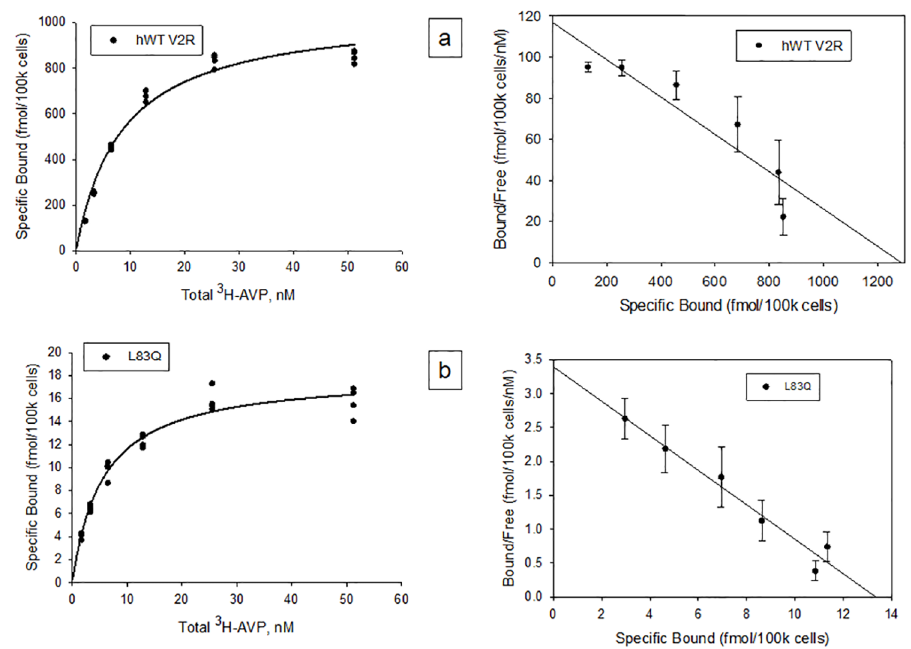
Fig 10. Scatchard assay of stably transfected HeLa cells with WT V2R or mutant. Stably transfected HeLa cells containingtTA + hWT V2R (a) or tTA + L83Q mutants (b) were used to determine the numberof receptors present at the membraneusing the scatchard assay. Six concentrations of 3 H-AVP (specific activity = 66.3 Ci/mmol) was used rangingfrom 1.56 to 50 nM with serial dilutionsof 1:2. The averaged receptors per cell, B max and K d for each of the 3 experiments is shownin the graph for the mutant and the WT V2R.